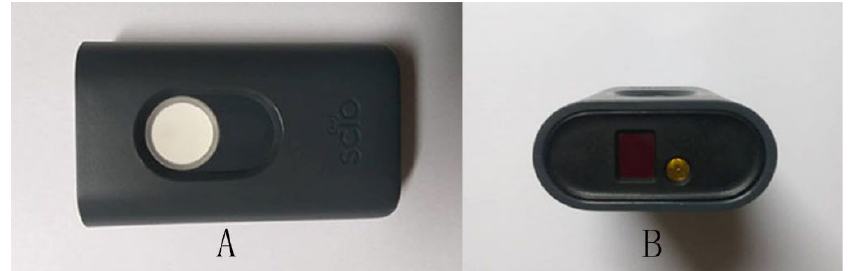
Figure 1. Consumer Physics VIS/SW-NIR molecular sensor, SCiO TM ( A ) VIS/SW-NIR spectrometer, ( B ) The location of light source and detector).